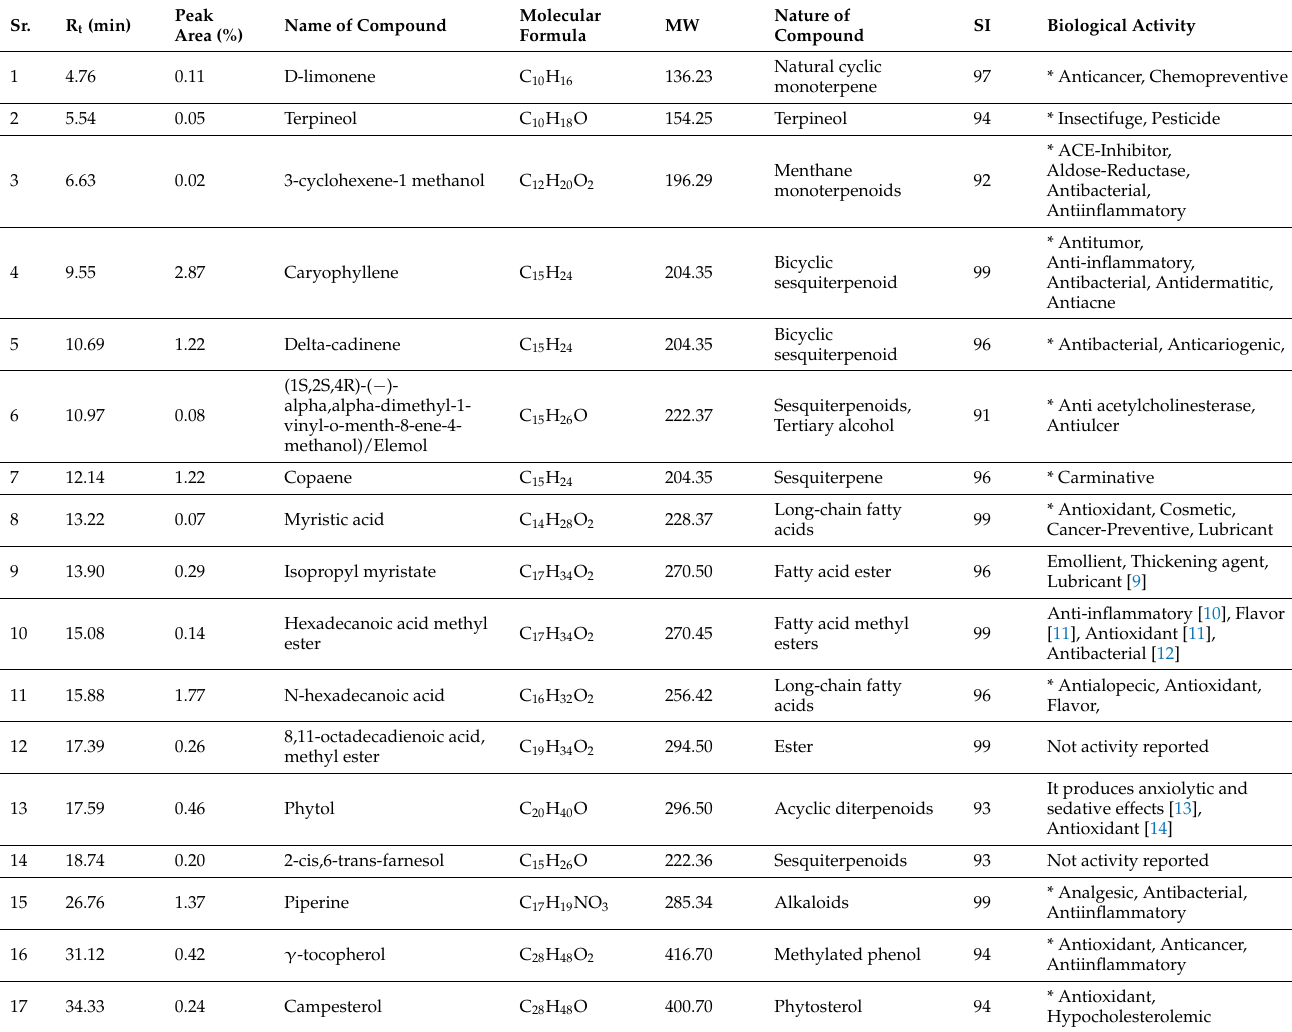
Table 1. Gas chromatography-mass spectroscopy (GC-MS) analysis of phyto-compounds in the ethanolic P. nigrum seed